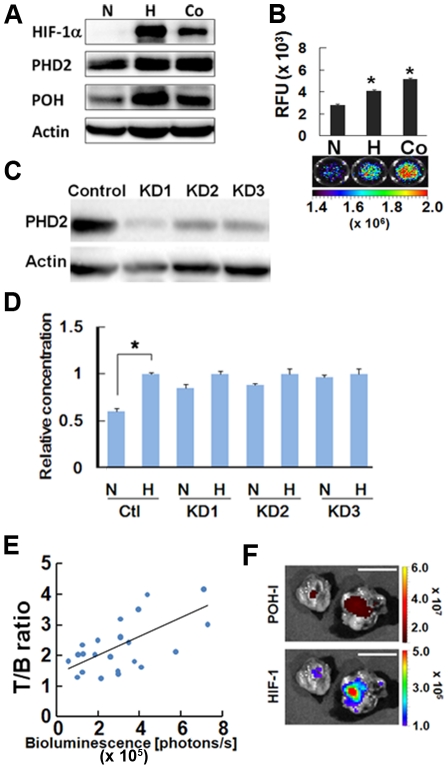
Characterization of POH probe in vitro and in vivo.(A and B) Correlation of POH stability and the expression of HIF-1α. The SUIT-2/HRE-Luc cells (1.5×105) cultured under normoxic (N) or hypoxic (H) conditions with 250 µM CoCl2 (Co), a HPHD inhibitor, were treated with POH protein and analyzed by western blotting (representative blot is shown) (A) and measurement of fluorescent intensity (B) with an Ex/Em wavelength of 710 nm/800 nm (P<0.05, n = 3). Representative fluorescence images are shown below the graphs. (C and D) PHD2 regulation of POH stability. The three independent SUIT-2/HRE-Luc/PHD2-KD cell lines (KD1, KD2 and KD3) with reduced PHD2 protein expression (C), which were isolated after stable transfection of a PHD2-specific shRNA plasmid into SUIT-2/HRE-Luc cells, were cultured under normoxic (N) or hypoxic (H) conditions and were treated with POH-I for 1 h. The cells were cultured in fresh medium and the probes remained in the cells was estimated by the measurement of fluorescent intensity of cell lysates. The experiments were repeated three times and a relative value (hypoxia  = 1) means ± SEM are shown (D). *P<0.05 (vs. normoxic condition). (E) Correlation between tumor bioluminescence intensity and the T/B ratio (relative fluorescence intensity of the tumors to the muscle). Bioluminescence and fluorescent intensities of xenografts were measured 24 h after POH-I administration. Bioluminescence intensity and T/B ratio show the coefficient value of 0.7767. n = 29. (F) Representative ex vivo bioluminescence (HIF-1) and fluorescence (POH-I) images of excised subcutaneous tumors. Nude mice carrying SUIT-2/HRE-Luc xenografts in both forefeet were injected with POH-I and dissected 24 h after probe administration. Bar  = 10 mm.